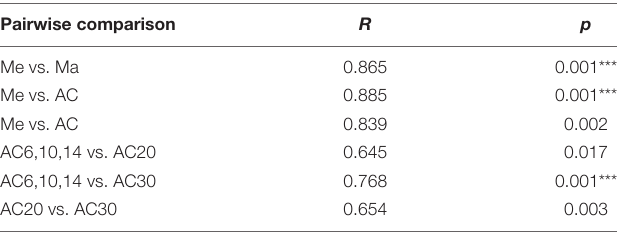
TABLE 2 | Effect of crop type and continuous cropping years on the differences of bacteria communities based on PERMANOVA analysis. Pairwise comparison R p